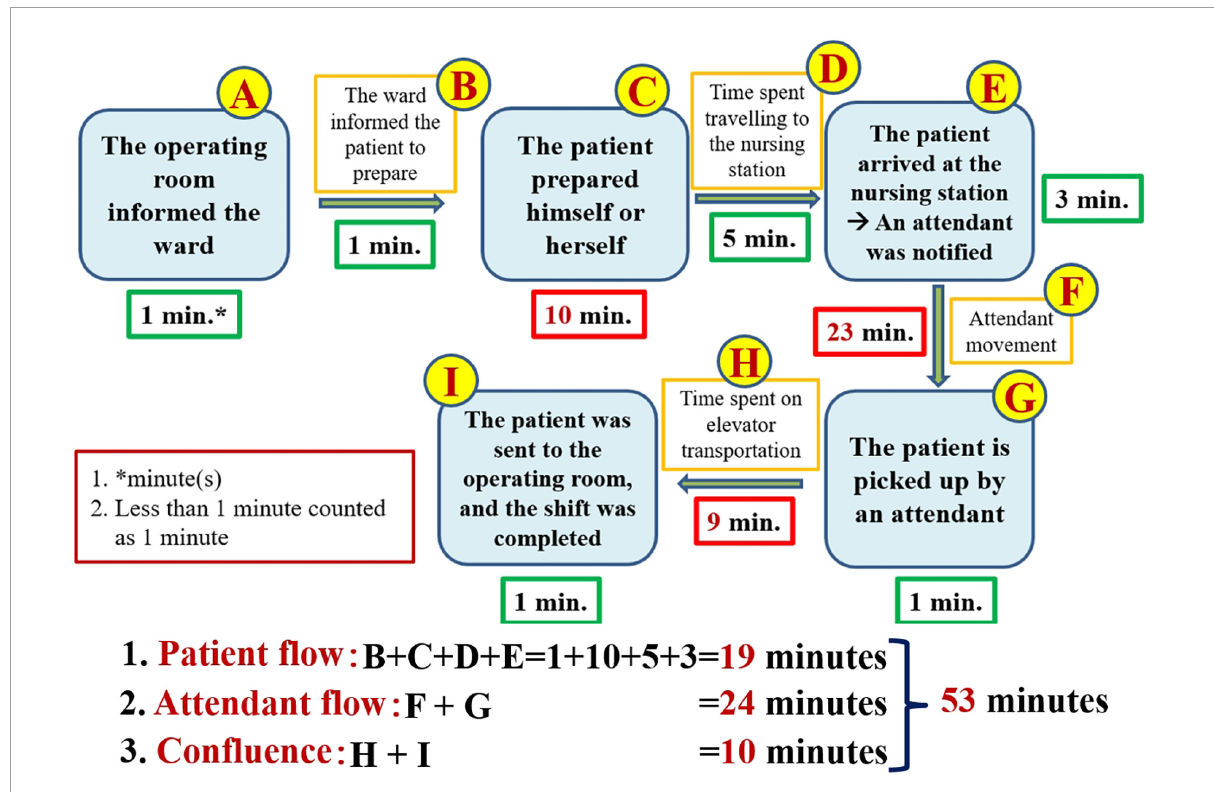
FIGURE3 Value stream map including the amount of time measured before